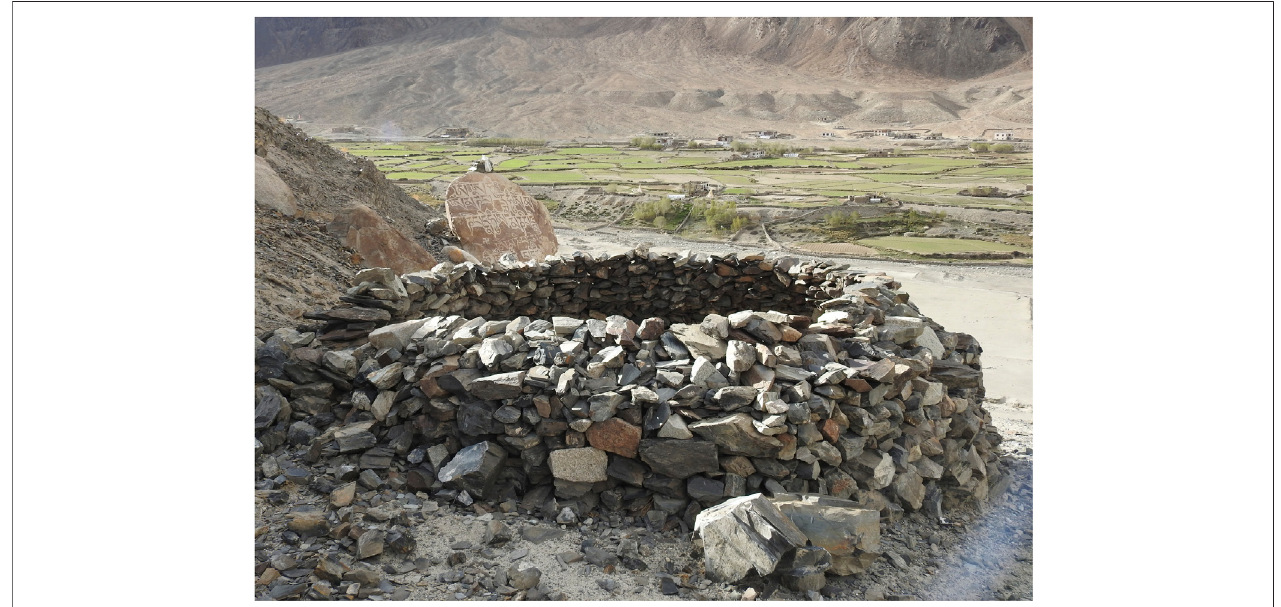
FIGURE4| Abaittrapused forkillingwolves.Agoatorasheepwouldbetiedinsideadeeppitsurroundedbythecircularwallseenabove,whichwouldattractthe wolf. The wolf can jump in and access the bait but is unable to jump out due to the concave walls of the trap.